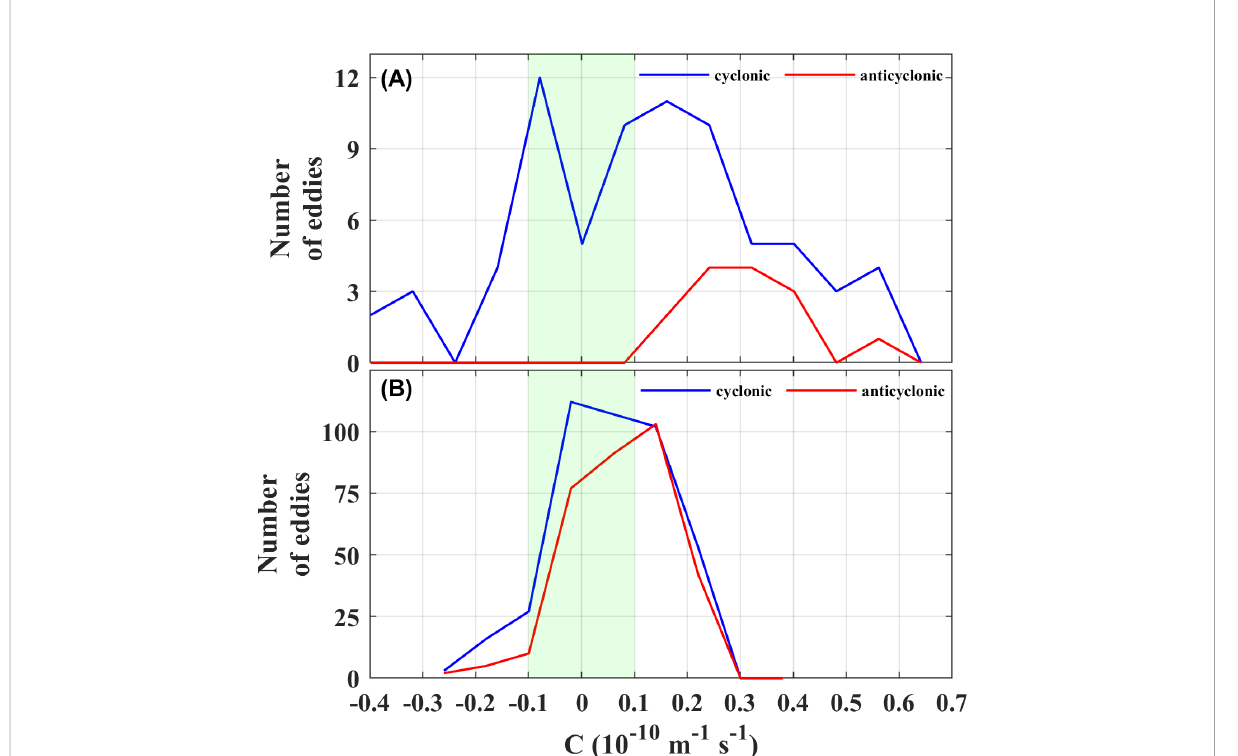
FIGURE 9 Distribution of the number of detected cyclonic and anticyclonic eddies as function of the gradient of large-scale absolute vorticity C at eddy generation sites for all eddies generated between 1993 and 2018 within: (A) northern part of NEB (region A) and (B) southern part of NEB (region B). Green vertical in (A, B) indicate interval values C within ± 0.1×10 -10 m -1 s -1